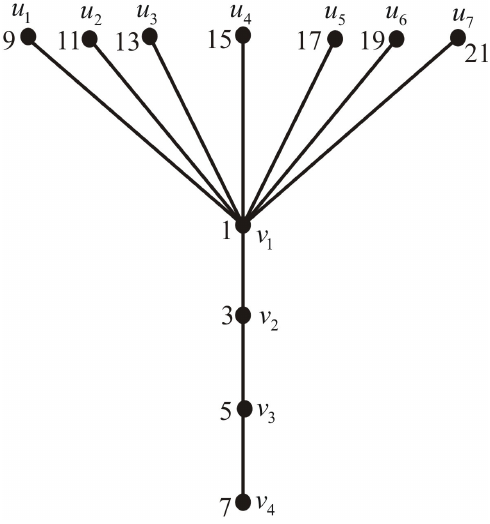
Figure 4: CT ( m, n ) and its odd prime